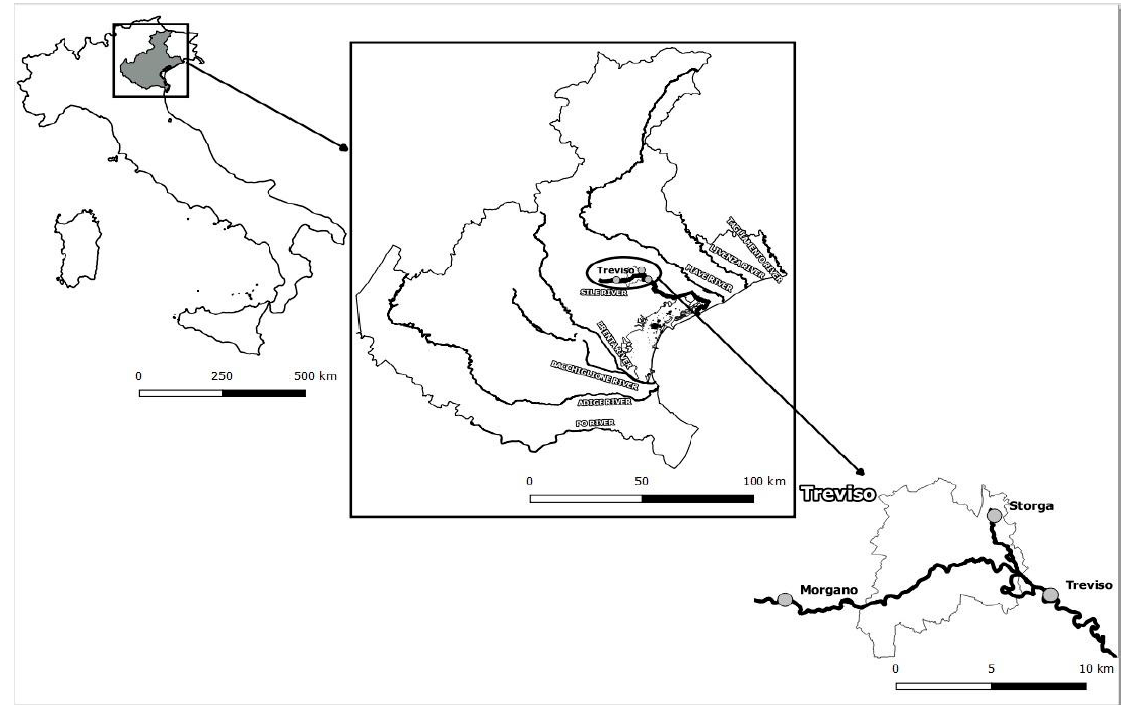
Figure 1. Sampling stations along Sile River, North Eastern Italy (Storga, Morgano and Treviso).